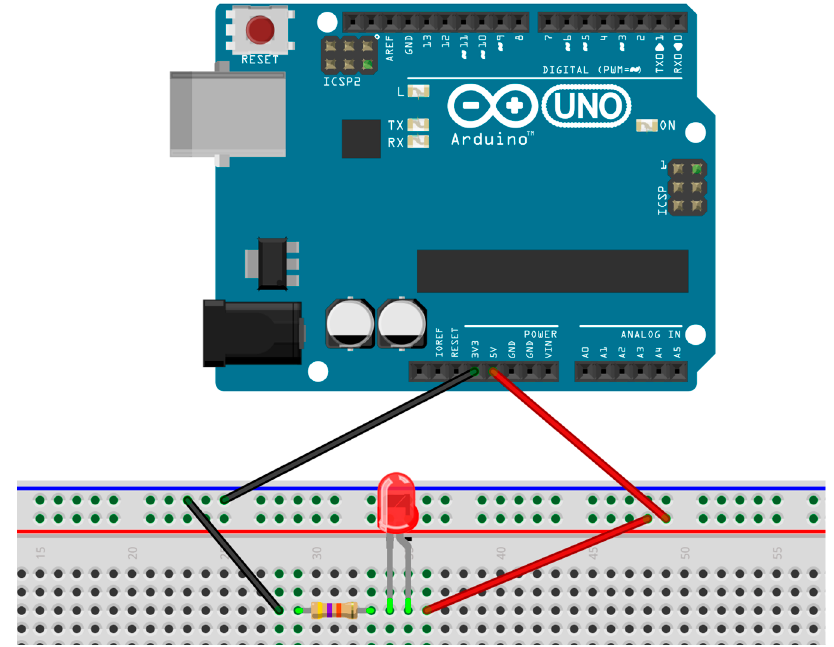
Figure 6. Diagrams as answers: fix the